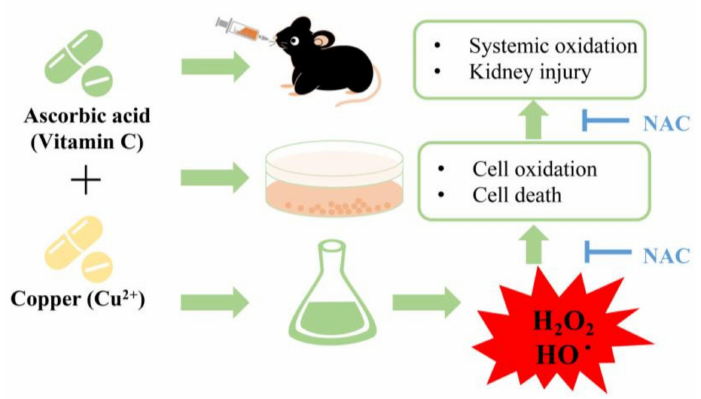
Figure 8. Schematic depiction of the effects and mechanisms of AA plus Cu 2+ on systemic oxidative status and renal injury. The combined administration of AA plus Cu 2+ resulted in H 2 O 2 generation, which causes renal tubular cell injury in vitro and systemic oxidative stress as well as kidney injury in vivo. This effects of AA plus Cu 2+ could be completely abolished by thiol antioxidant